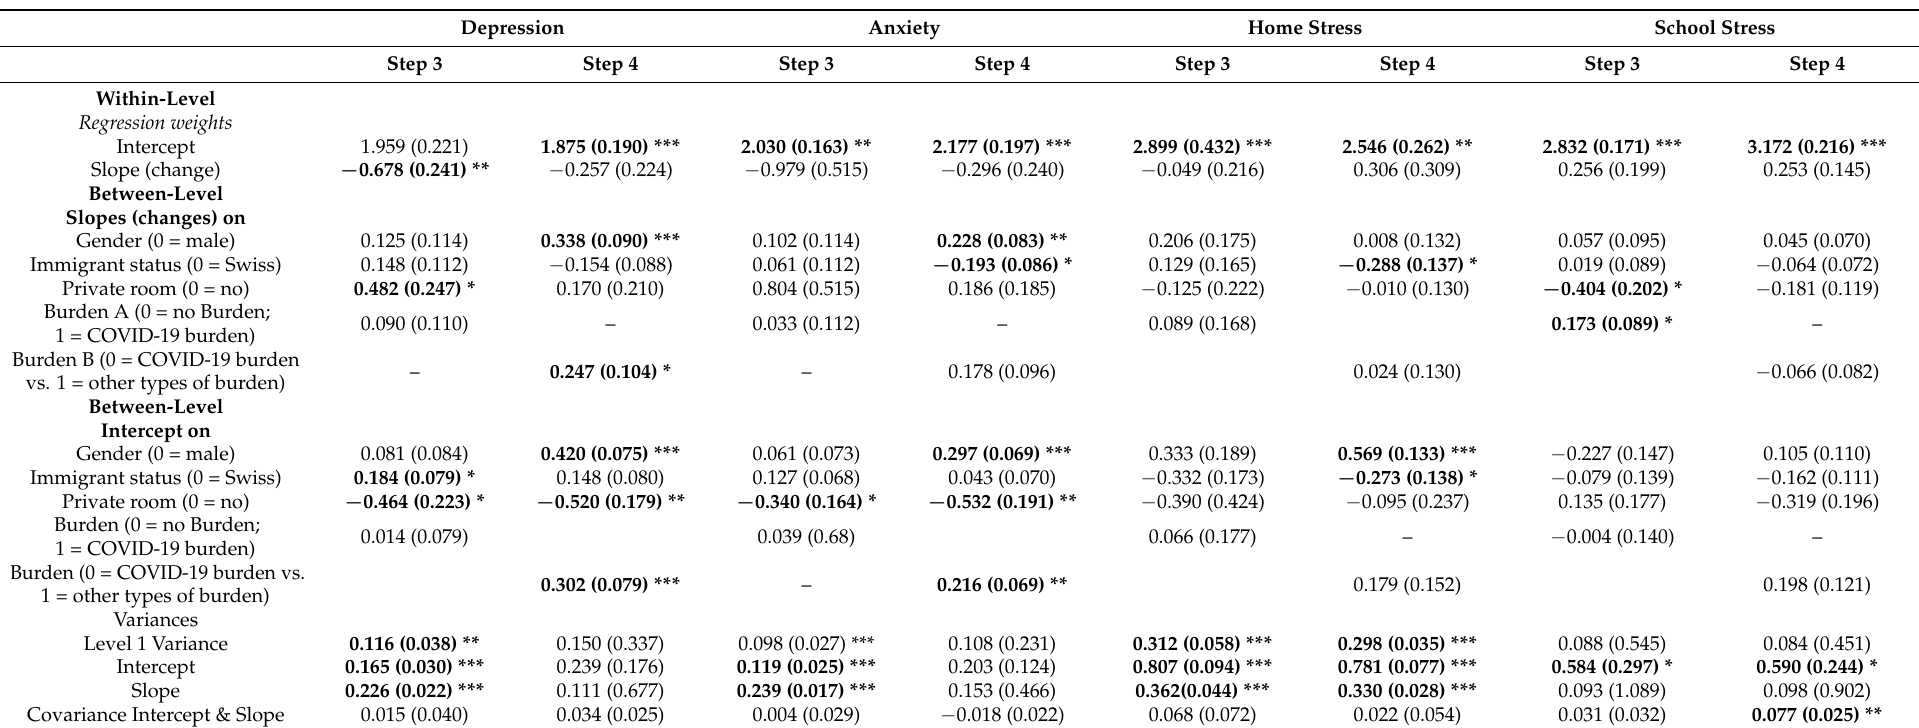
Variances Level 1